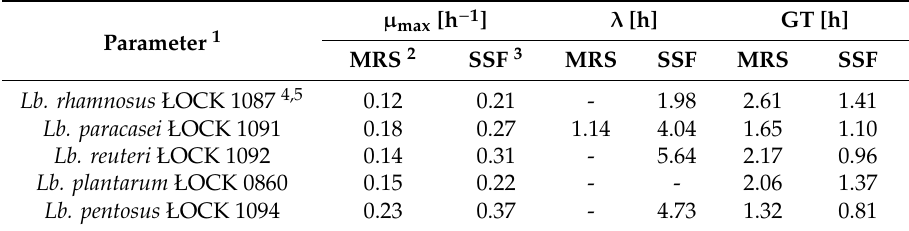
Table 3. Growth parameters of selected Lactobacillus spp. probiotic strains cultivated in MRS and the SFF